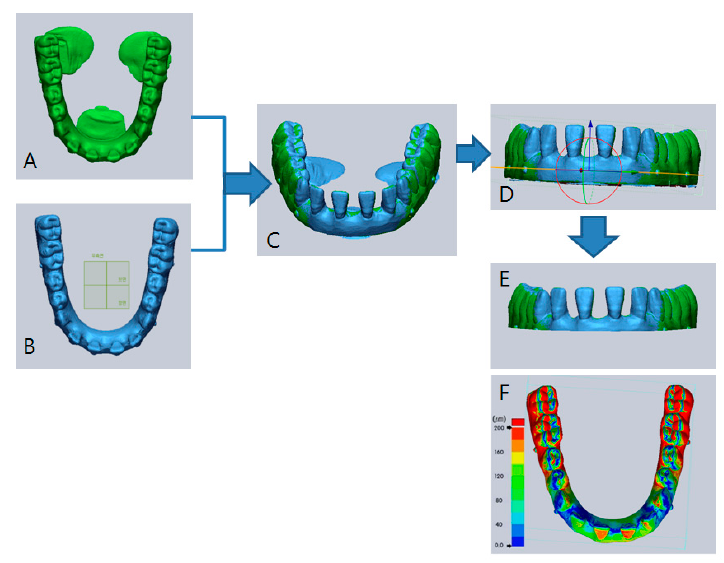
Figure 4. Illustration of superimposed models and division sequence using Geomagic Verify™. ( A ) Scanned data from the reference scanner with the Severe model; ( B ) Scanned data from iTero ® with the Severe model; ( C ) Superimposed model using the best-fit algorithm between ( A ) and ( B ); ( D ) A reference plane set with resin-balls for cutting the base of the superimposed model; ( E ) Finished product of a superimposed model after cutting the base; ( F ) Colored representation showing deviations after superimposition. Red represents areas of high deviation (around 200 μ m). Blue represents areas of low deviation (around 0 μ m).